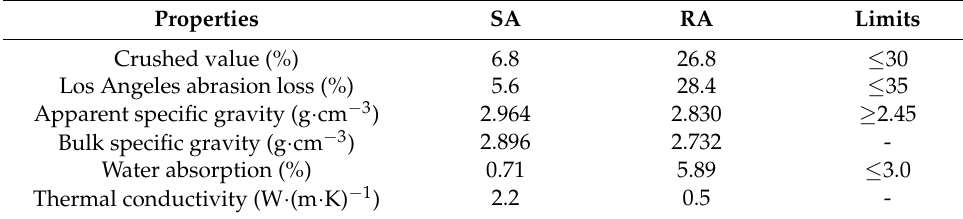
Table 4. Properties of coarse aggregates.